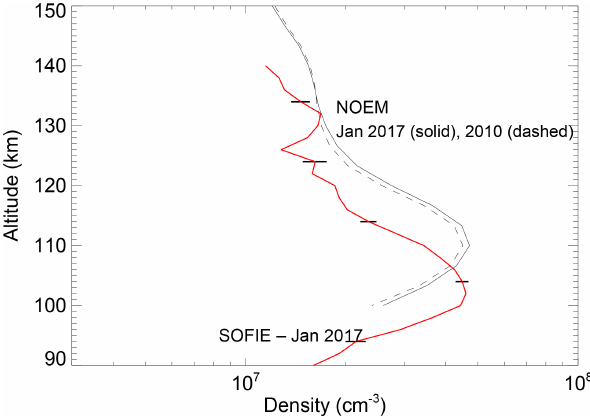
Figure 2. Averaged January 2017 SOFIE NO profile (red) com- pared with the nitric oxide empirical model (NOEM) for January 2010 and January 2017. The horizonal black lines on the SOFIE profile represent a 1 σ variation of the daily zonal mean averages about the monthly